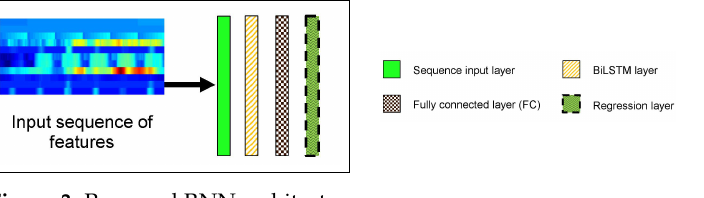
Figure 3. Proposed RNN architecture.